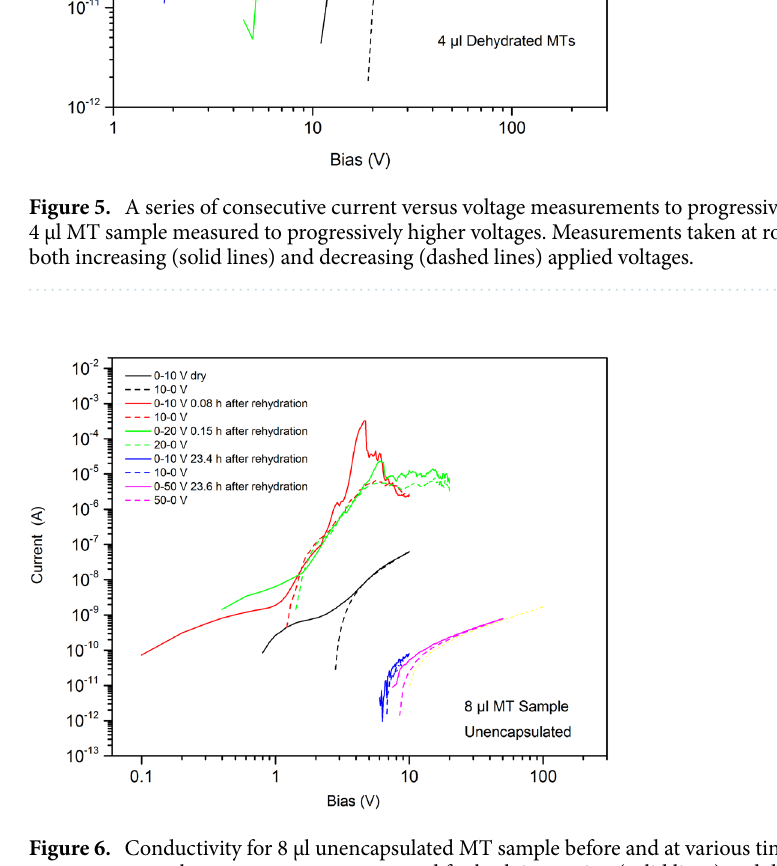
Figure 6. Conductivity for 8 µl unencapsulated MT sample before and at various times following hydration measurements taken at room temperature and for both increasing (solid lines) and decreasing (dashed lines) applied